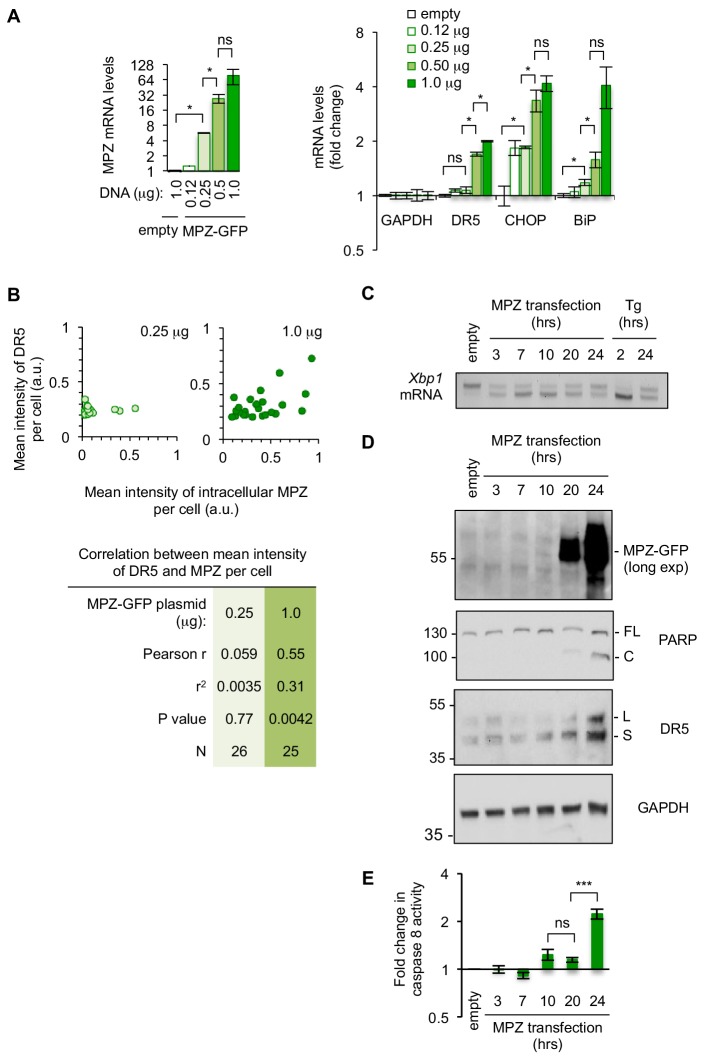
Sustained MPZ-GFP expression invokes a terminal, pro-apoptotic UPR at late time points.(A) qPCR for reverse-transcribed transcripts harvested from HCT116 cells transfected with 0.12–1.0 μg of a plasmid containing myelin protein zero (MPZ) tagged with a C-terminal monomeric EGFP or 1.0 μg of the empty vector for 24 hr (n = 3 technical replicates, error bars = SD; * denotes p<0.05 as analyzed by multiple t-tests with Holm-Sidak correction for multiple comparisons). (B) Quantification of the mean intensity for DR5 versus the mean intensity of intracellular MPZ-GFP per cell for HCT116 transfected with 0.25 μg (left) and 1.0 μg (right) of MPZ-GFP plasmid to show the correlation between DR5 and MPZ-GFP expression levels per cell. Intensity values given by CellProfiler algorithms were normalized to 0.02 for DR5 and 0.06 for MPZ-GFP to assign arbitrary values. P values were calculated from unpaired two-tailed t-tests. (C) RT-PCR for unspliced and spliced forms of Xbp1 mRNA isolated from HCT116 cells transfected for 24 hr with the empty vector or for various time points with 1 μg MPZ-GFP, followed by cells treated with 100 nM Tg for 2 hr and 24 hr. (D) Western blot of HCT116 cell lysates harvested 24 hr post-transfection with the empty vector, or 3–24 hr post-transfection with 1 μg MPZ-GFP. (E) Fold change in caspase 8 activity, as measured by a luminescent caspase glo 8 substrate, of lysates from HCT116 harvested 3–24 hr post-transfection with 1 μg MPZ-GFP relative to cells transfected with the empty vector control (error bars represent SD of n = 3 technical replicates; *** denotes p<0.005, and ns indicates p=0.15 by unpaired t-test with equal SD).